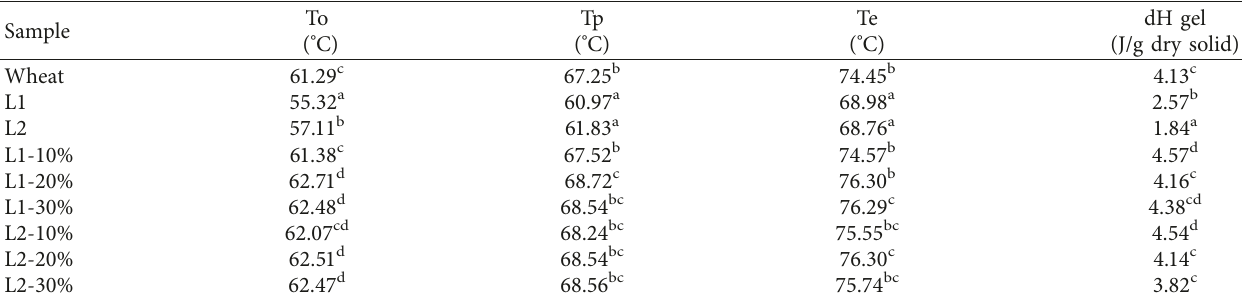
Table 2: Gelatinization parameters of wheat and both kañawa flours (L1 and L2) and their blends. Sample